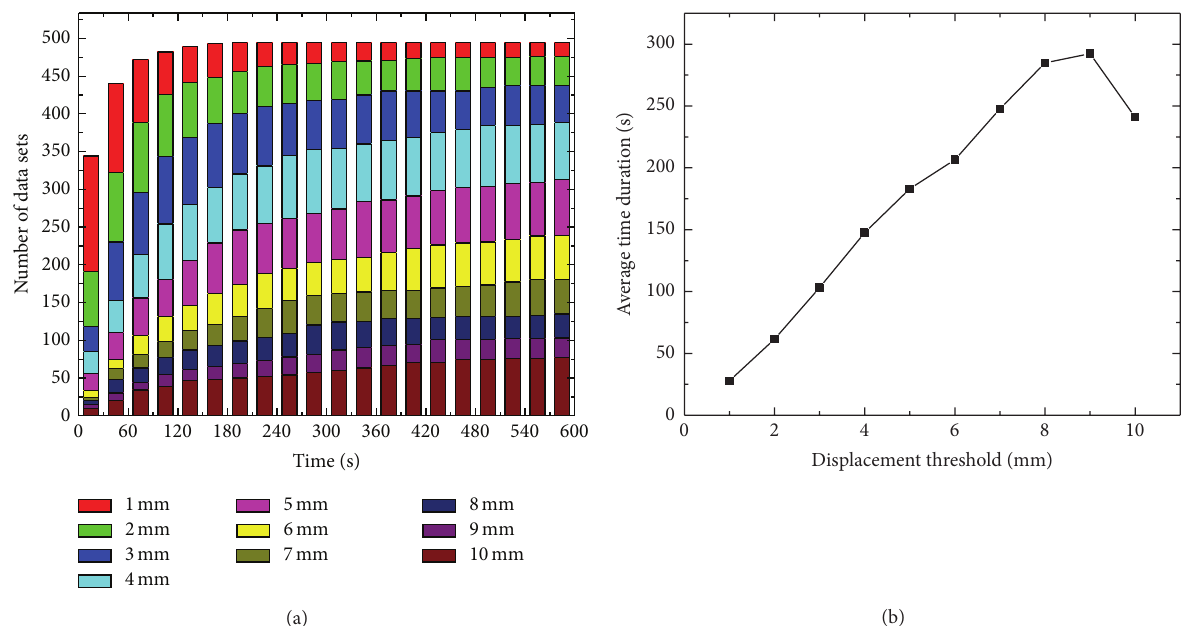
Figure5:Determinationofacquisitiontimeforintrafractionalmotionofpancreas.(a)Histogramoftimecumulativedistributionfordifferent movement distances; (b) average time duration against displacement